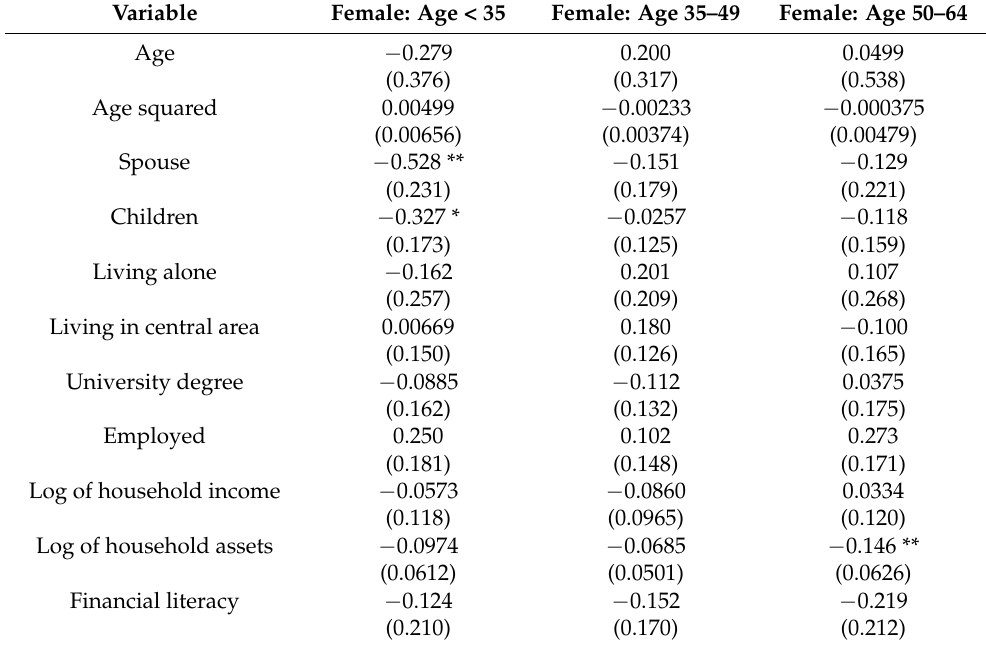
Table 5. Results of probit regression analysis regarding younger females’ reluctance to receive the third dose of COVID-19